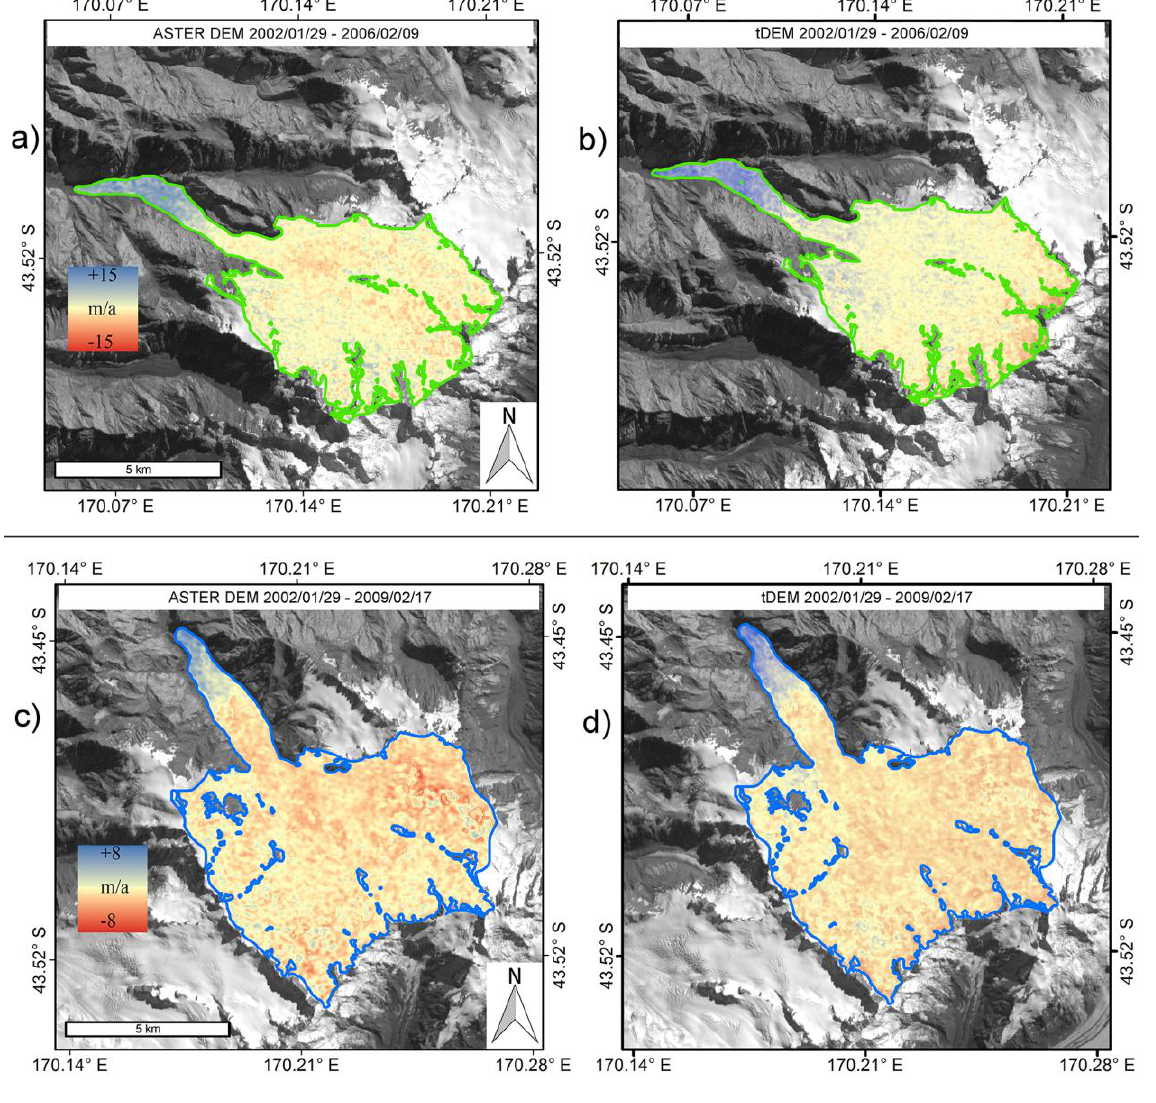
Figure 10. ( a ) Elevation change on Fox Glacier from differencing of ASTER DEMs of 2002 and 2006. ( b ) Difference of two reconstructed DEMs of the same dates. ( c ) Elevation change on Franz Josef Glacier from ASTER DEMs of 2002 and 2009. ( d ) Difference of two reconstructed DEMs of the same dates. Underlying ASTER image of 2006/02/09. Both glaciers show slight thickening at the